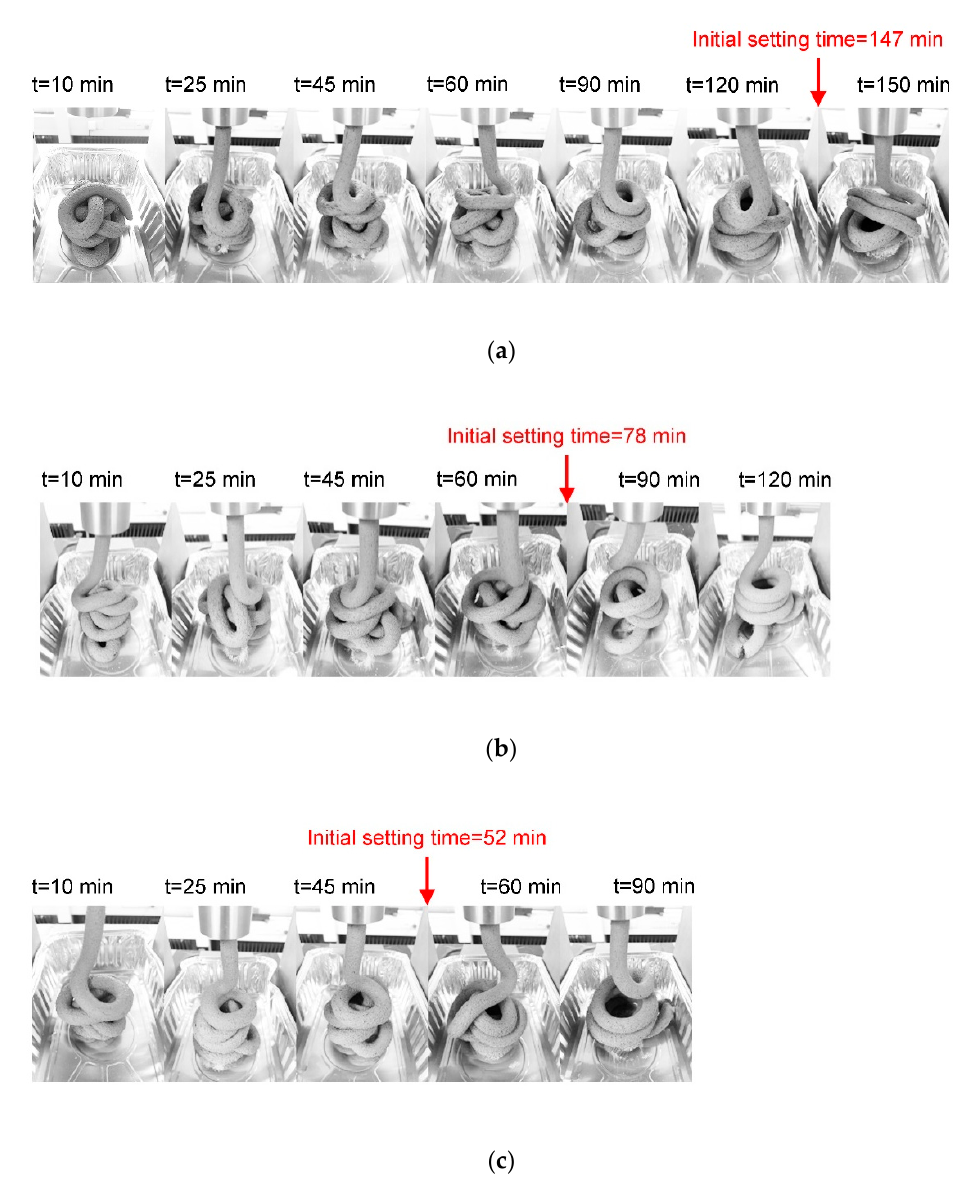
Figure 7. ( a ) Extruded filaments of mixture MIX-L; ( b ) Extruded filaments of mixture MIX-M; ( c ) Extruded filaments of mixture